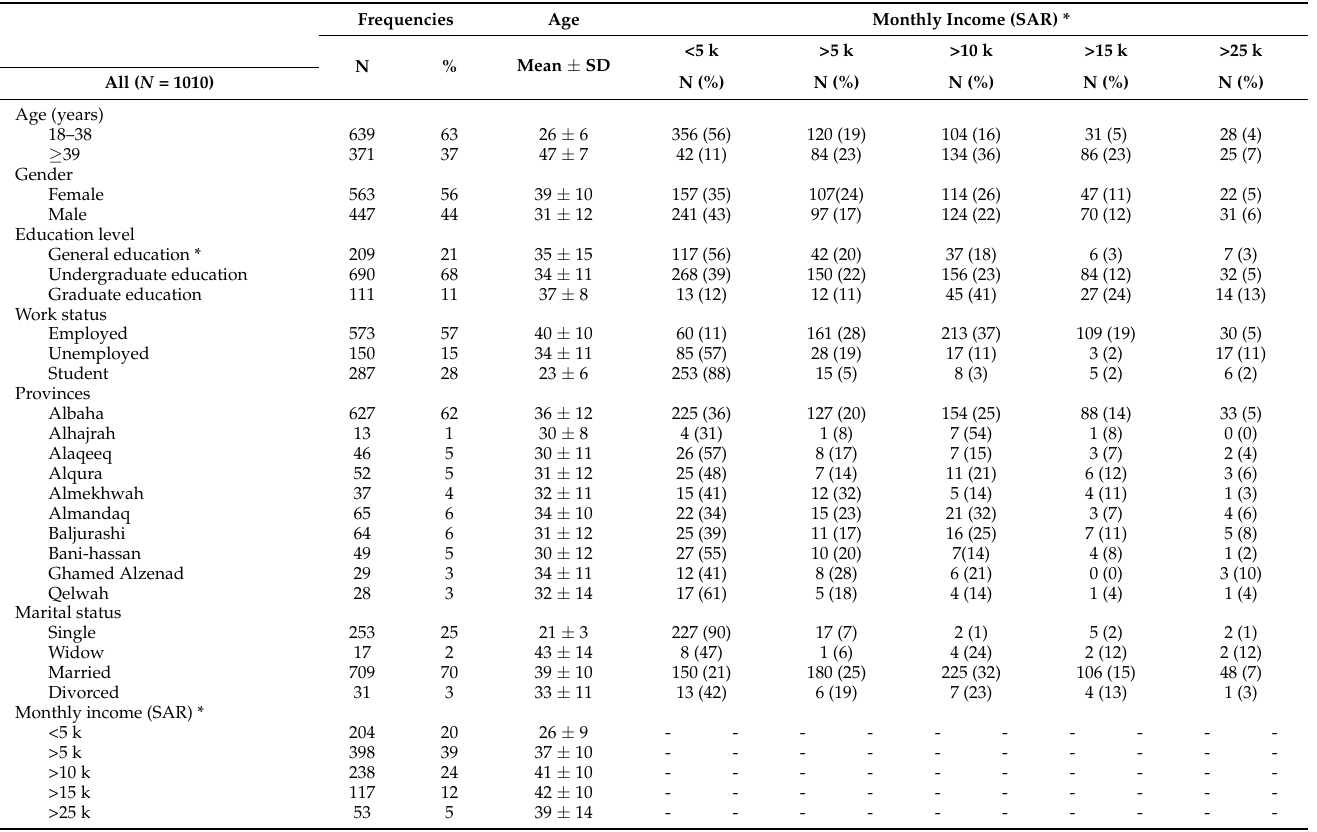
Table 1. Sociodemographic characteristics of the